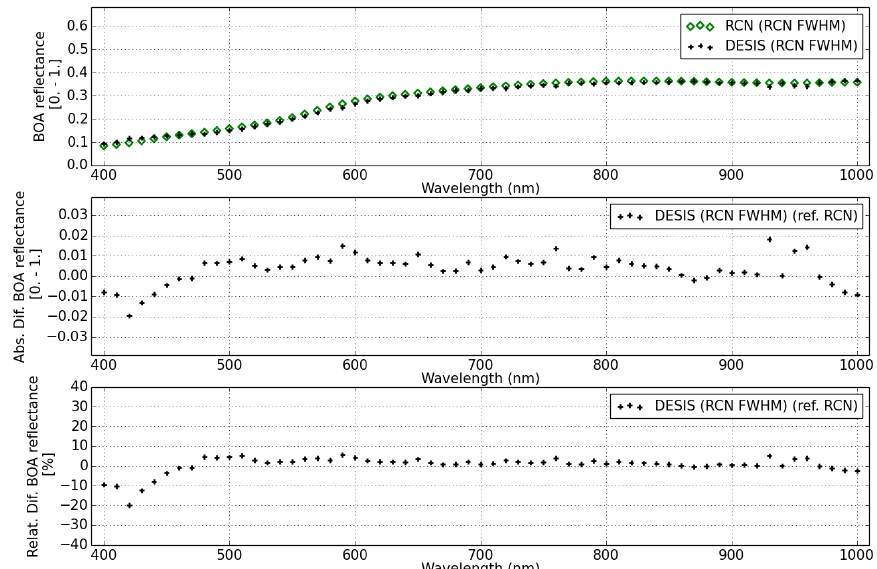
Figure 24. DESIS (black crosses) and RadCalNet (green diamonds) BOA surface reflectances at Gobabeb site (4 February 2019). DESIS spectrum at 2.5 nm has been convolved with RadCalNet spectral response: ( top ) BOA surface reflectance; ( center ) absolute difference of surface reflectance; and ( bottom ) Relative difference (%) of surface reflectance.